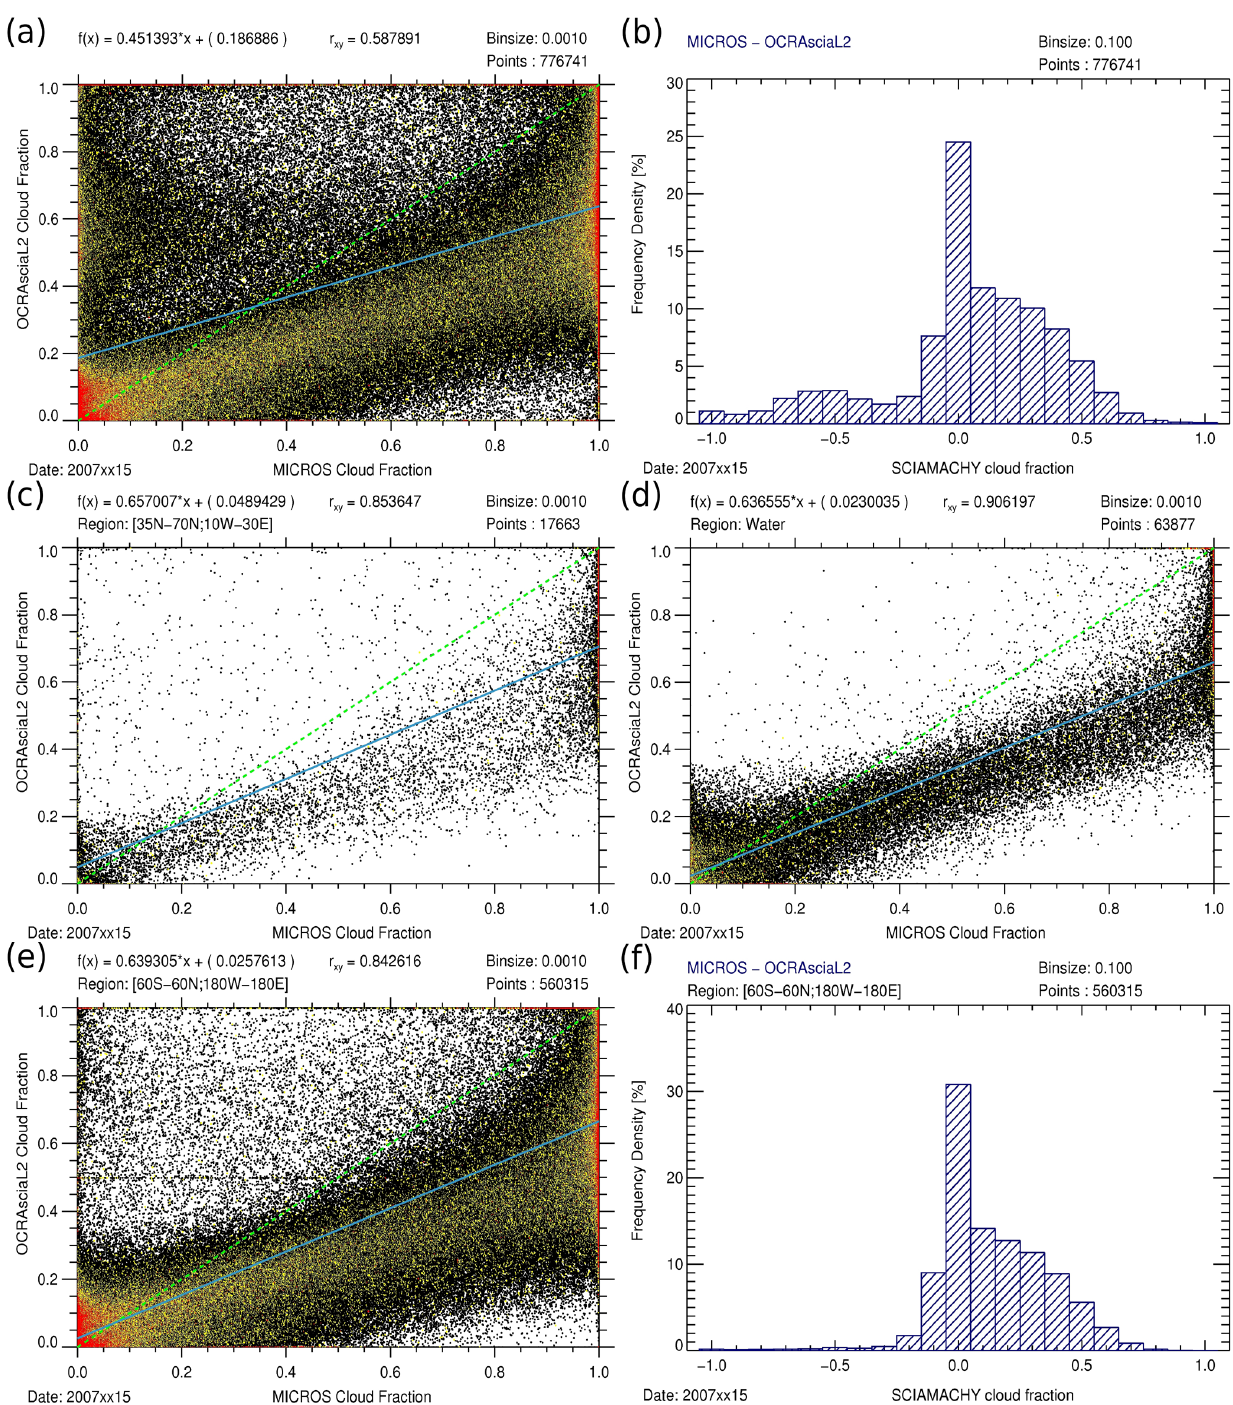
Fig. 9. Intercomparison of SCIAMACHY cloud fractions derived from the MICROS (optically thick clouds) and OCRA algorithms consid- ering each 15th in 2007: (a) Cross-validation for all cloud fractions, (b) difference histogram with respect to (a) , (c) cloud fractions over Europe [35 ◦ N–70 ◦ N; 10 ◦ W–30 ◦ E], (d) cloud fractions over water, (e) cloud fractions at mid- and low-latitudes [60 ◦ S–60 ◦ N; 180 ◦ W– 180 ◦ E] and (f) difference histogram with respect to (e) . The colour code of the two dimensional density function plots [ (a) , (c) , (d) , (e) ] is the following: If only one measurement is located inside of a bin, the result is coloured in black. If more than 1 but less than 4 measurements are located inside of a bin, the result is coloured in yellow. If more than 4 measurements are located inside of a bin, the results is coloured in